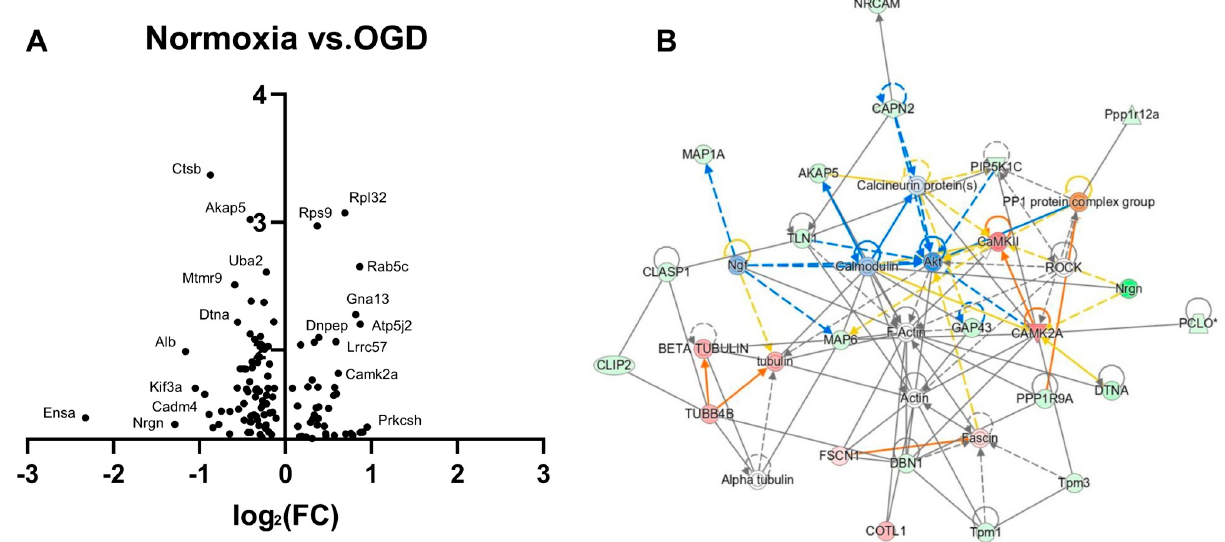
Figure 5. Post-OGD recovery reveals upregulation of actin signalling and mitochondrial dysfunction. ( A ) A volcano plot of proteomic changes shows dramatically changed expression of targets involved in potassium channel regulation (Ensa) and LTP (Nrgn), while the most significantly associated targets are implicated in lysosome function (Ctsb) and dendritic endosomal trafficking (AKAP5). ( B ) Ingenuity network enrichment analysis ( p = 1.00 × 10 − 48 ) reveals actin to be a central node of the network analysis, in addition to targets regulating synaptic plasticity (CAMKII) and microtubule- mediated transport Table 2. Ingenuity canonical pathway analysis post-OGD. Signi fi cant ingenuity pathway analysis, ranked by − log ( p -value), shows synaptic plasticity (PKA; p = 5.3 × 10 − 5 ) and OGD-associated tran- script degradation ( p = 5.8 × 10 − 5 ), in addition to mitochondrial dysfunction ( p = 9.5 × 10 − 5 ) amongst the top pathways, compared to normoxia-treated slices.